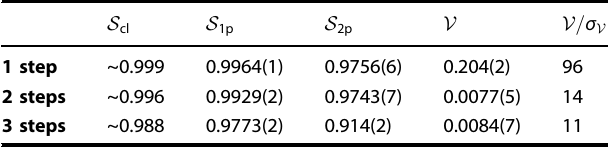
Table 1. Similarities of distributions related to classical, one particle, and two-particle regime for all the steps.